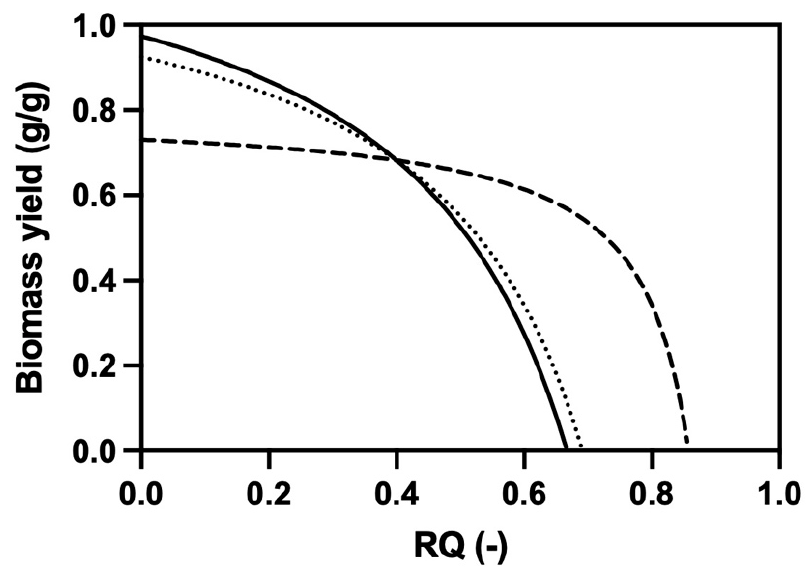
Figure 2. Stoichiometric relation between RQ and biomass yield on ethanol ( ____ ), glycerol (- - -), or the combination of ethanol and glycerol provided in the feed ( ... ... ), i.e., a molar ratio of ethanol:glycerol of 8:1. The three curves were calculated using Equations (8)–(10).